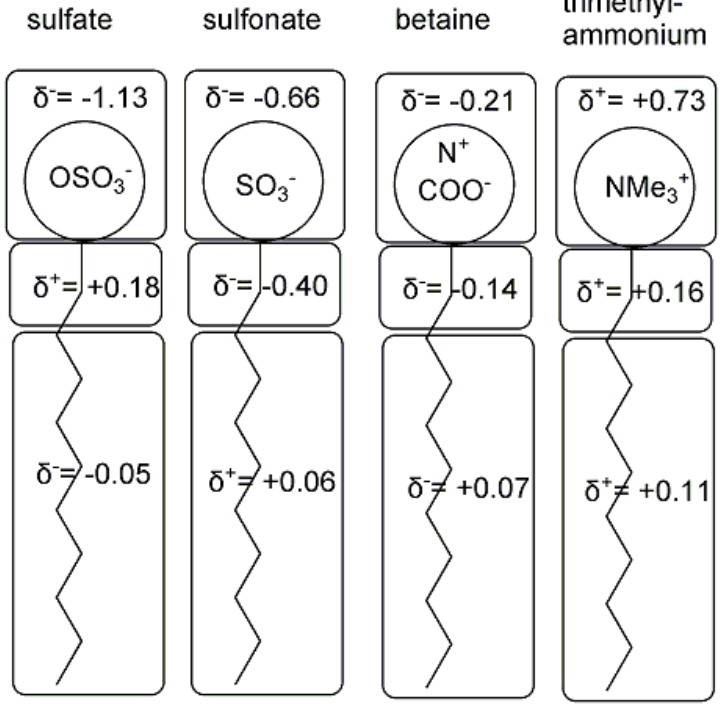
Figure 4. Distribution of charge in selected surfactants between the head group, the α -methylene, and the remaining portion